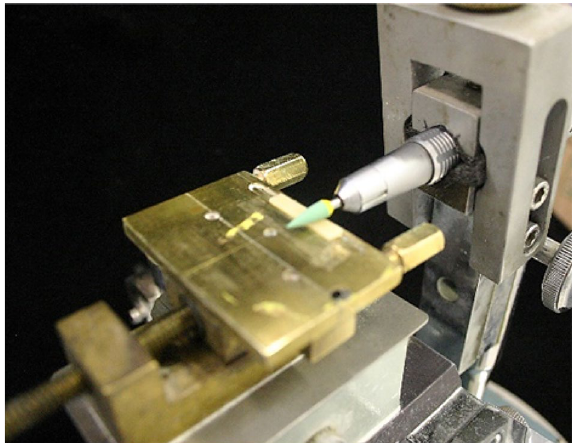
Figure 6. Parallelometer and load control applied during the